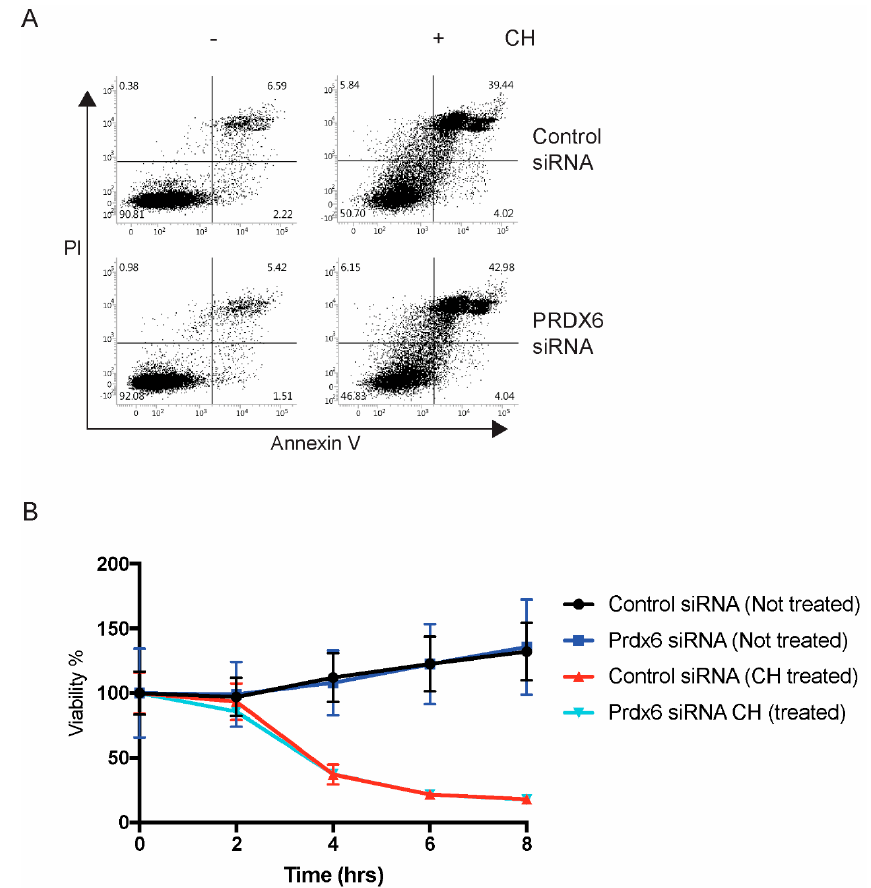
Figure 4. Normal apoptosis in the absence of Prdx6. ( A ) B4G12 CEnCs were treated with CH (100 µ m) for 4 h and stained with Annexin V and propidium iodide (PI). Representative FACS plots are shown and the percentages of viable (AnV − PI − ), early, (AnV + PI − ), late apoptotic (AnV + PI + ), and necrotic (AnV − PI + ) are shown. ( B ) B4G12 CEnC cells were seeded on xCELLigence plates and continuously monitored for 8 h after the addition of CH (50 µ